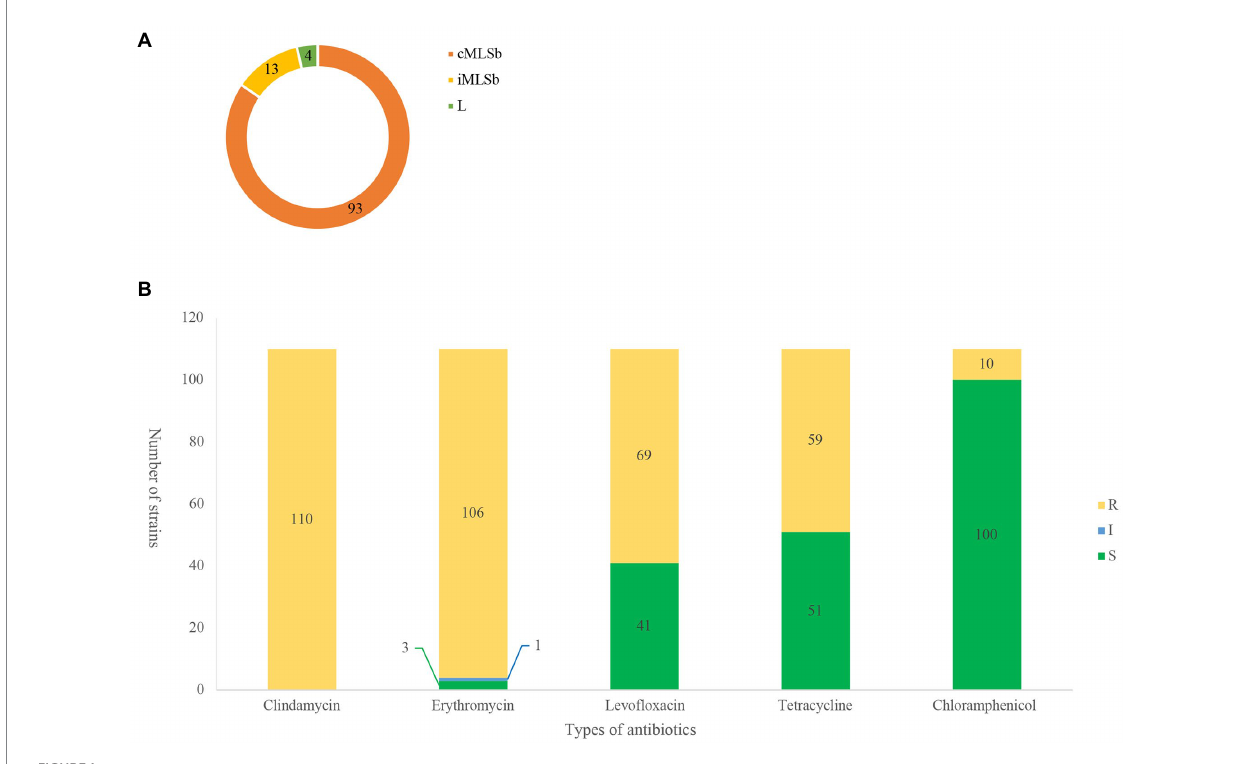
FIGURE 1 MLSb phenotypes and antibiotic susceptibility. Numbers of the different colours represent the number of strains ( n = 110). (A) . Distribution of clindamycin/erythromycin resistant phenotypes in 110 clindamycin-resistant Streptococcus agalactiae strains. ( B) . Antibiotic resistant profiles of 110 clindamycin-resistant S. agalactiae strains. R, resistance; I, intermediate; S, sensitive.